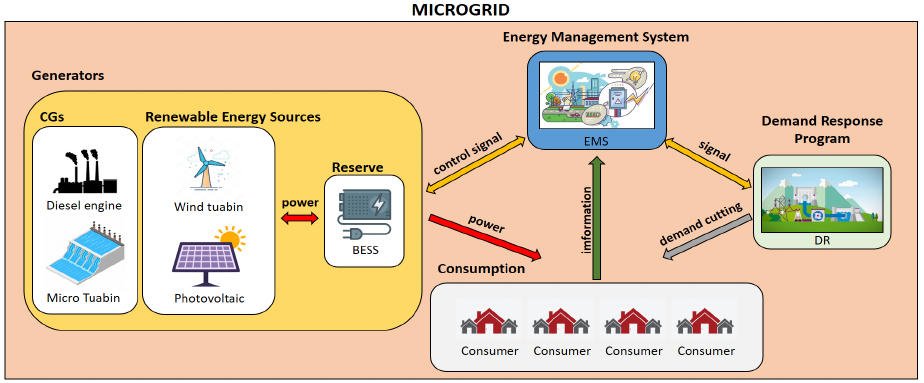
Figure 1. Structure of the considered